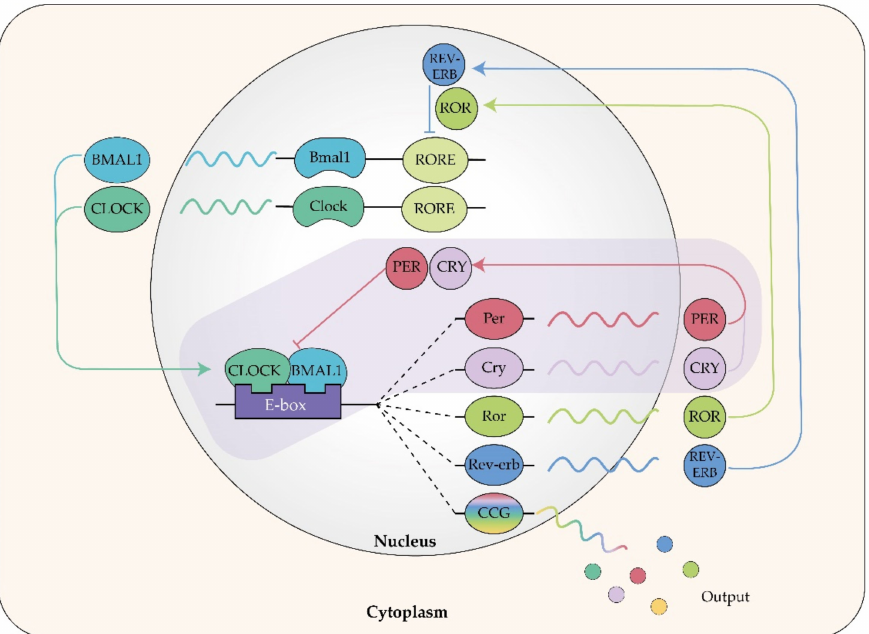
Figure 3. Transcriptional feedback loops of the mammalian circadian clock. Circadian locomotor output cycles coat (CLOCK) and brain-muscle-aryl hydrocarbon receptor nuclear translocator-like protein 1 (BMAL1) are transcription factors that form heterodimer and bind to E-boxes in the nucleus to promote the expression of the period circadian protein (PER) and cryptochrome (CRY) genes. Resulting PER and CRY proteins heterodimerize and return to the nucleus to inhibit their expression by binding to and inactivating BMAL1/CLOCK. The image was created with the Adobe Illustrator CC (Version 23.0.1.; Adobe Inc., 2019)